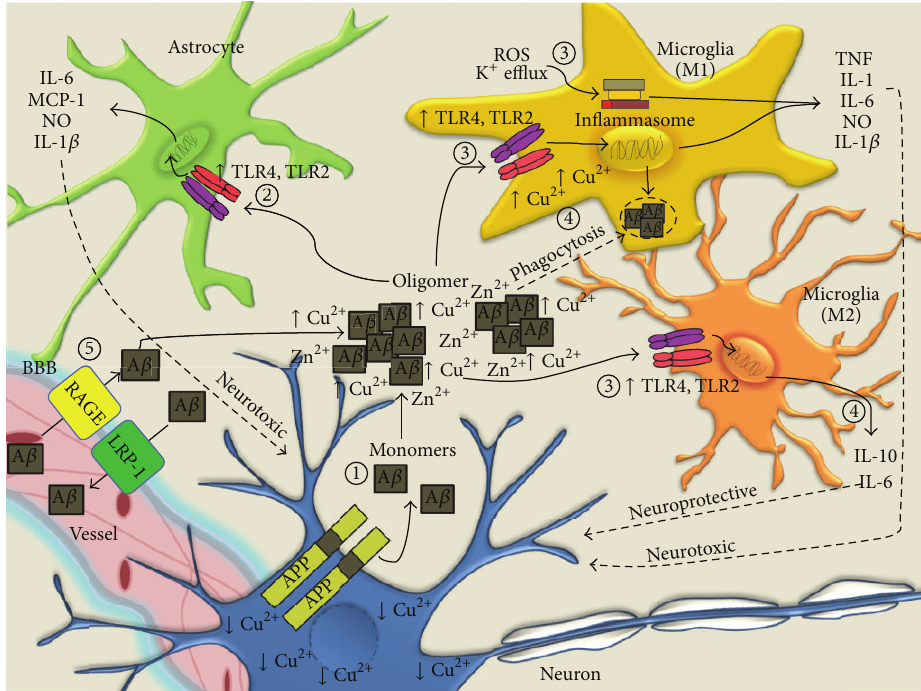
Figure 1: Inflammatory processes in AD . (1) Sequential cleavage of APP by secretase proteins generates extracellular A 𝛽 monomers, which aggregate to form toxic oligomers and plaques, a process accelerated by Cu and Zn ions. (2) A 𝛽 oligomers may directly interact with immune components on astrocytes, potentially through TLR2/4 recognition, resulting in astrocyte-derived secretion of toxic proinflammatory mediators that act on neurons. (3) Microglia surrounding A 𝛽 plaques may be polarised to the neurotoxic M1 phenotype through A 𝛽 - or ROS- dependentinflammasomeandTLRactivation.(4)MicrogliamayalsoexertprotectivefunctionsthroughintracellularCusequestration,direct phagocytic activity on plaques, and secretion on neuroprotective M2 mediators including IL-10. (5) The brain levels of A 𝛽 are also controlled by RAGE- and LRP-1 mediated transport between the plasma and brain. Increased vascular RAGE in AD contributes to impaired clearance of A 𝛽 from the